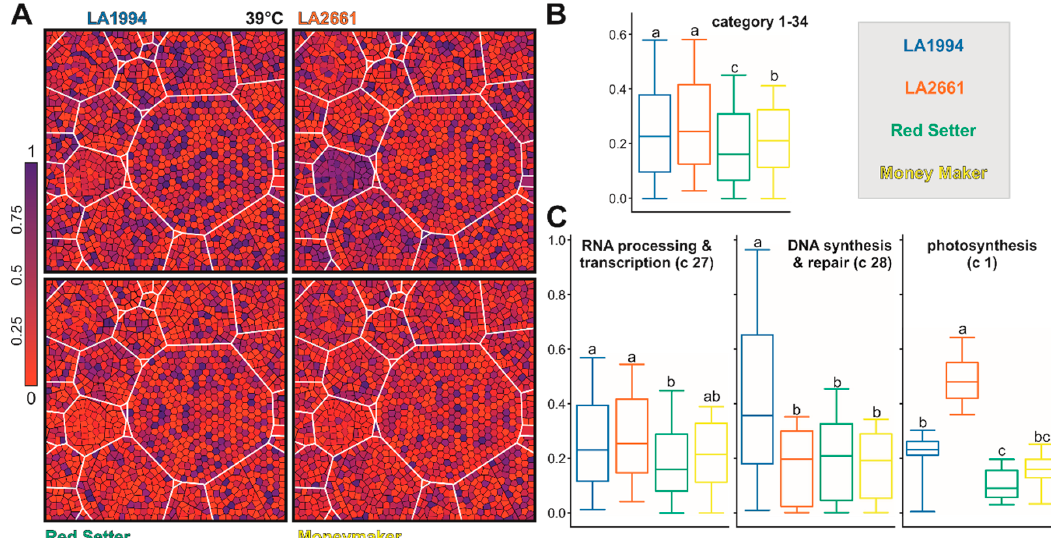
Figure 6. The genes contributing to PC1 and PC2 after 39 °C HS application. ( A ) The Voronoi Treemap representation of the transcript level for the indicated genotypes according to the scheme shown in Figure 5A is shown. The coloring (shown on the left) indicates a lower (red) or higher transcript abundance (violet and blue) than expected for an equal transcript abundance in all genotypes (= 0.25). ( B , C ) Box plot representations of the distribution of the normalized transcript abundance values used for the Voronoi Treemap in ( A) for all genes (except not assigned; B ) or for all genes of the indicated MapMan categories ( C ) is shown. Statistical significance ( p < 0.05) of the difference was tested by One-Way ANOVA (Tukey test). The color code for the boxes accords to the name coloring of the legend. At 45 °C, the transcript level of the selected genes is globally reduced in LA2661 and Red Setter when compared to LA1994 (especially photosystem, blue in LA1994, Figure 7A,B). Further, in LA1994 an overall higher abundance of the transcripts of genes involved in photosynthesis, RNA- and DNA- based regulation, cell function and transport was observed (Figures 7C, Figure S5; Tables S9–S11). In turn, the transcripts of genes involved in hormone-based regulation show the lowest levels in LA1994 at this temperature (Figures 7C).